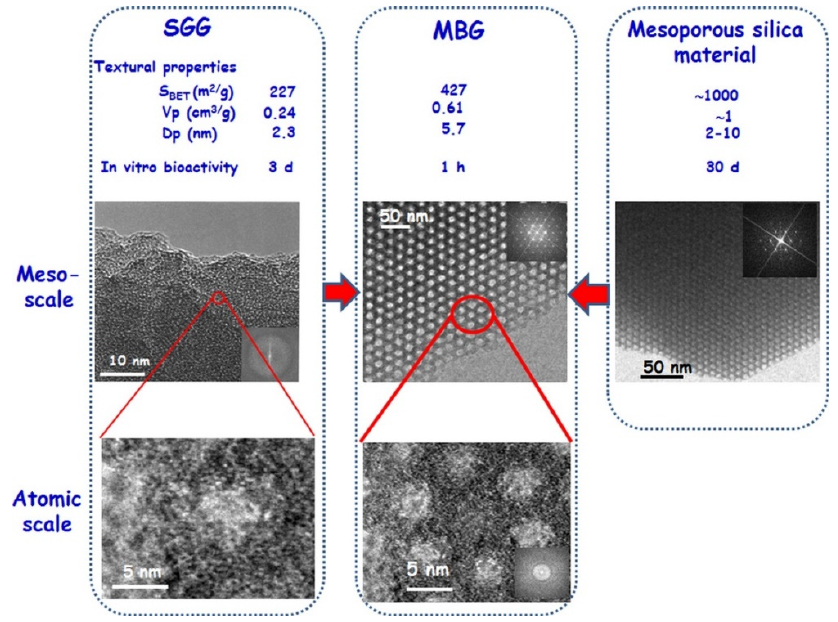
Figure 9. High-resolution transmission electron microscopy images and electron diffraction patterns of